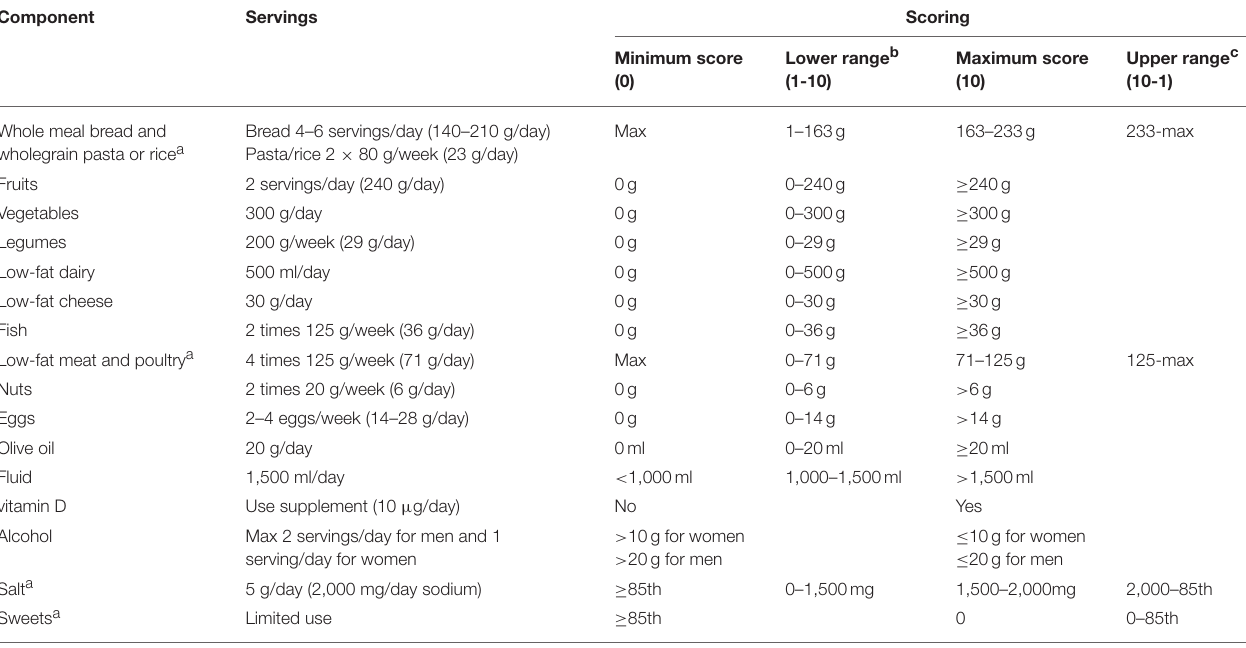
TABLE 4 | Components of the NU-AGE index and their cut-off (maximum score) and threshold (minimum score) values (55).